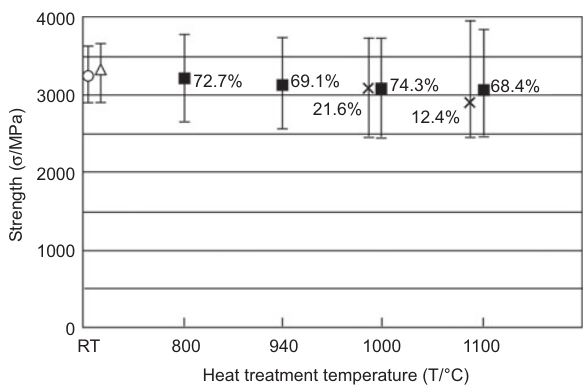
Figure 4 A white zone (W) was observed in the pyrolytic graphite. F, newly formed graphite; O, original pyrolitic graphite.